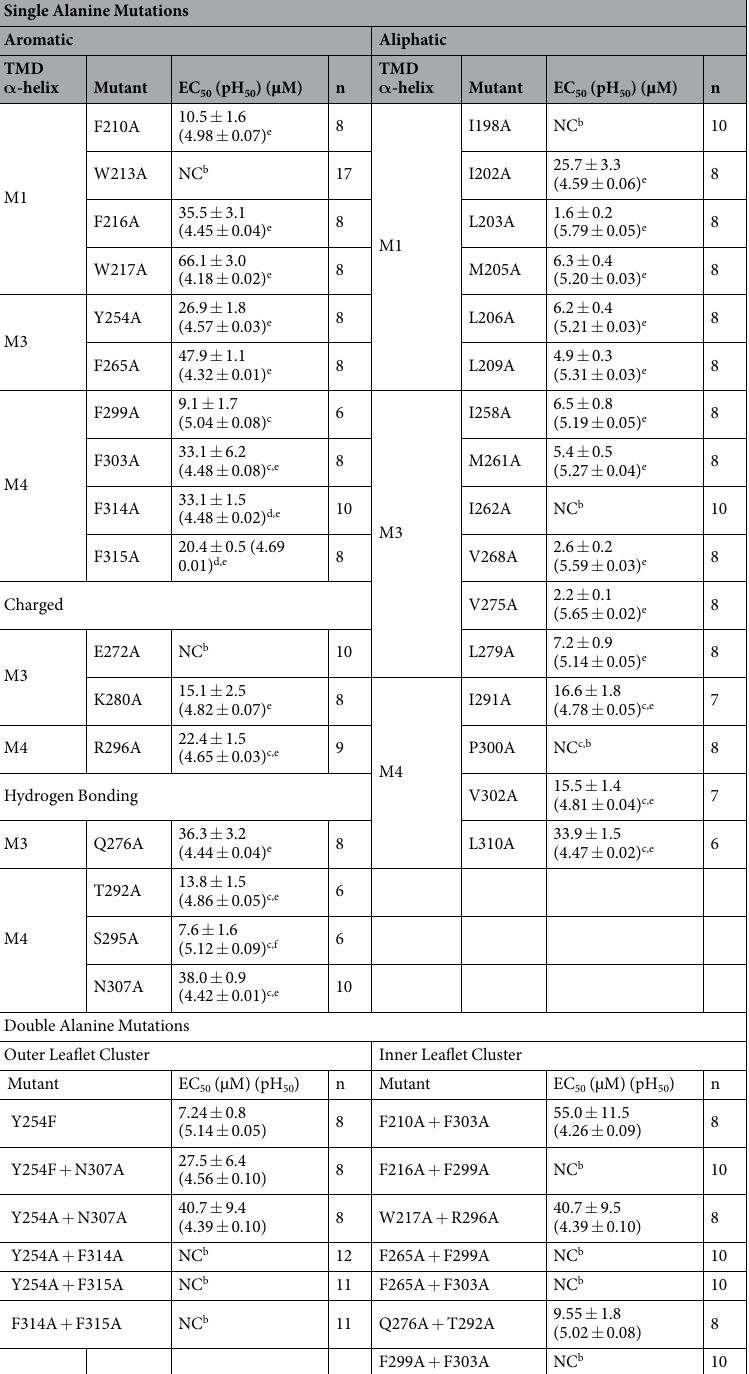
Table 1. The Functional Effects of Alanine Mutations of Residues located at the M4-M1/M3 Interface of GLIC. a Data collected 1–4 day(s) after cRNA injection (V − 20 to − 40 mV). Error Values represent Hold ranging from the standard deviation. b No current (NC) observed in oocytes after 1–4 day(s) of cRNA injection. c Data taken from Henault et al . 9, 18, 29 . d Data taken from Carswell et al . 23, 24 . e p < 0.001 relative to the pH 50 of WT GLIC via one-way ANOVA followed by Dunnet’s post hoc test. f p < 0.01 relative to the pH 50 of WT GLIC via one-way ANOVA followed by Dunnet’s post hoc GLIC aromatic residues. The interface between M4 and M1/M3 in GLIC contains a network of ten densely packed and interacting aromatic residues, with one additional aromatic, W217 on M1, involved in a cation- π interaction with R296 on M4. These ten aromatic residues interact with each other via canonical π - π stacking or